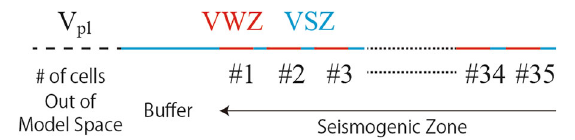
Fig. 1 Model space of the numerical simulations. Only the left half of the model space is shown here because the system is bilaterally symmetric. Red and blue lines denote velocity-weakening zones (VWZs) and velocity-strengthening zones (VSZs), respectively. Cells (pairs of VWZ and VSZ) are numbered from #1 at the edge to #35 at the center of the fault. A wide VSZ is set at the edge of the model space. The region outside the model space is assumed to slip stably at the plate